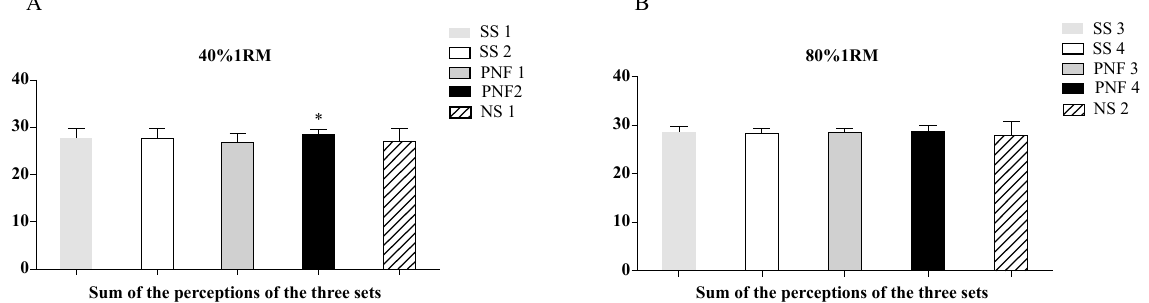
Figure 4. Comparative analysis of the sum of the perception of effort of the three series among the